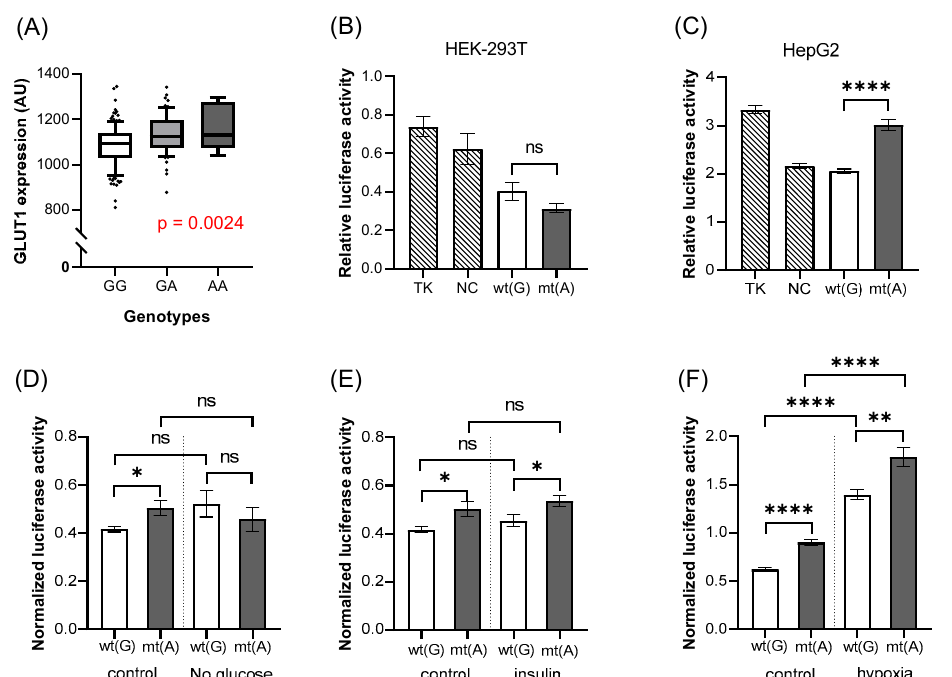
Figure 5. The effects of rs11537641 on GLUT1 expression and luciferase activity. The association between the expression of the GLUT1 membrane protein and the genotypes of the examined variant ( A ). Each boxplot represents samples with different genotypes, in the range of 10–90 percentile, while dots represent samples out of range. Luciferase activity in HEK ‐ 293T ( B ) and HepG2 ( C – F ) cells, under the effect of the insert containing the rs11537641 variant. This insert has decreased luciferase activity compared to the “empty” vector. In the presence of the mutant allele, luciferase activity does not show significant differences in HEK ‐ 293T ( B ) cells, but it shows in HepG2 ( C ) cells. The p ‐ values of the luciferase experiments ( B – F ) were calculated using the Welch t ‐ test. The stars represent significance at different levels: * p < 0.05, ** p < 0.01, **** p < 0.0001. Treatments ( D – F ) do not have a big influence on the results, although hypoxia increases luciferase expression, regardless of the alleles. In the case of the treatments, data were normalized to the results of the “empty” vector. Stars representing the strength of the significance; wt(G): wild ‐ type allele; mt(A): mutant allele; TK: “empty” vector without insert; NC: negative control (random sequence); ns: not significant; AU: arbitrary unit.